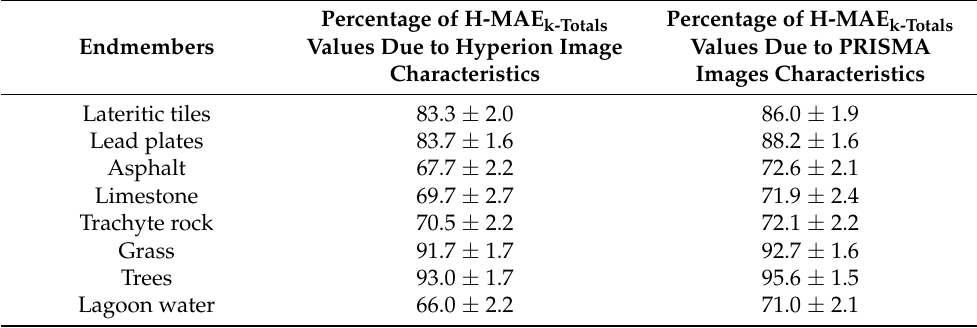
Table 7. The percentage of H-MAE k-Totals values due to the sensor characteristics added to the biases in the simulation of real